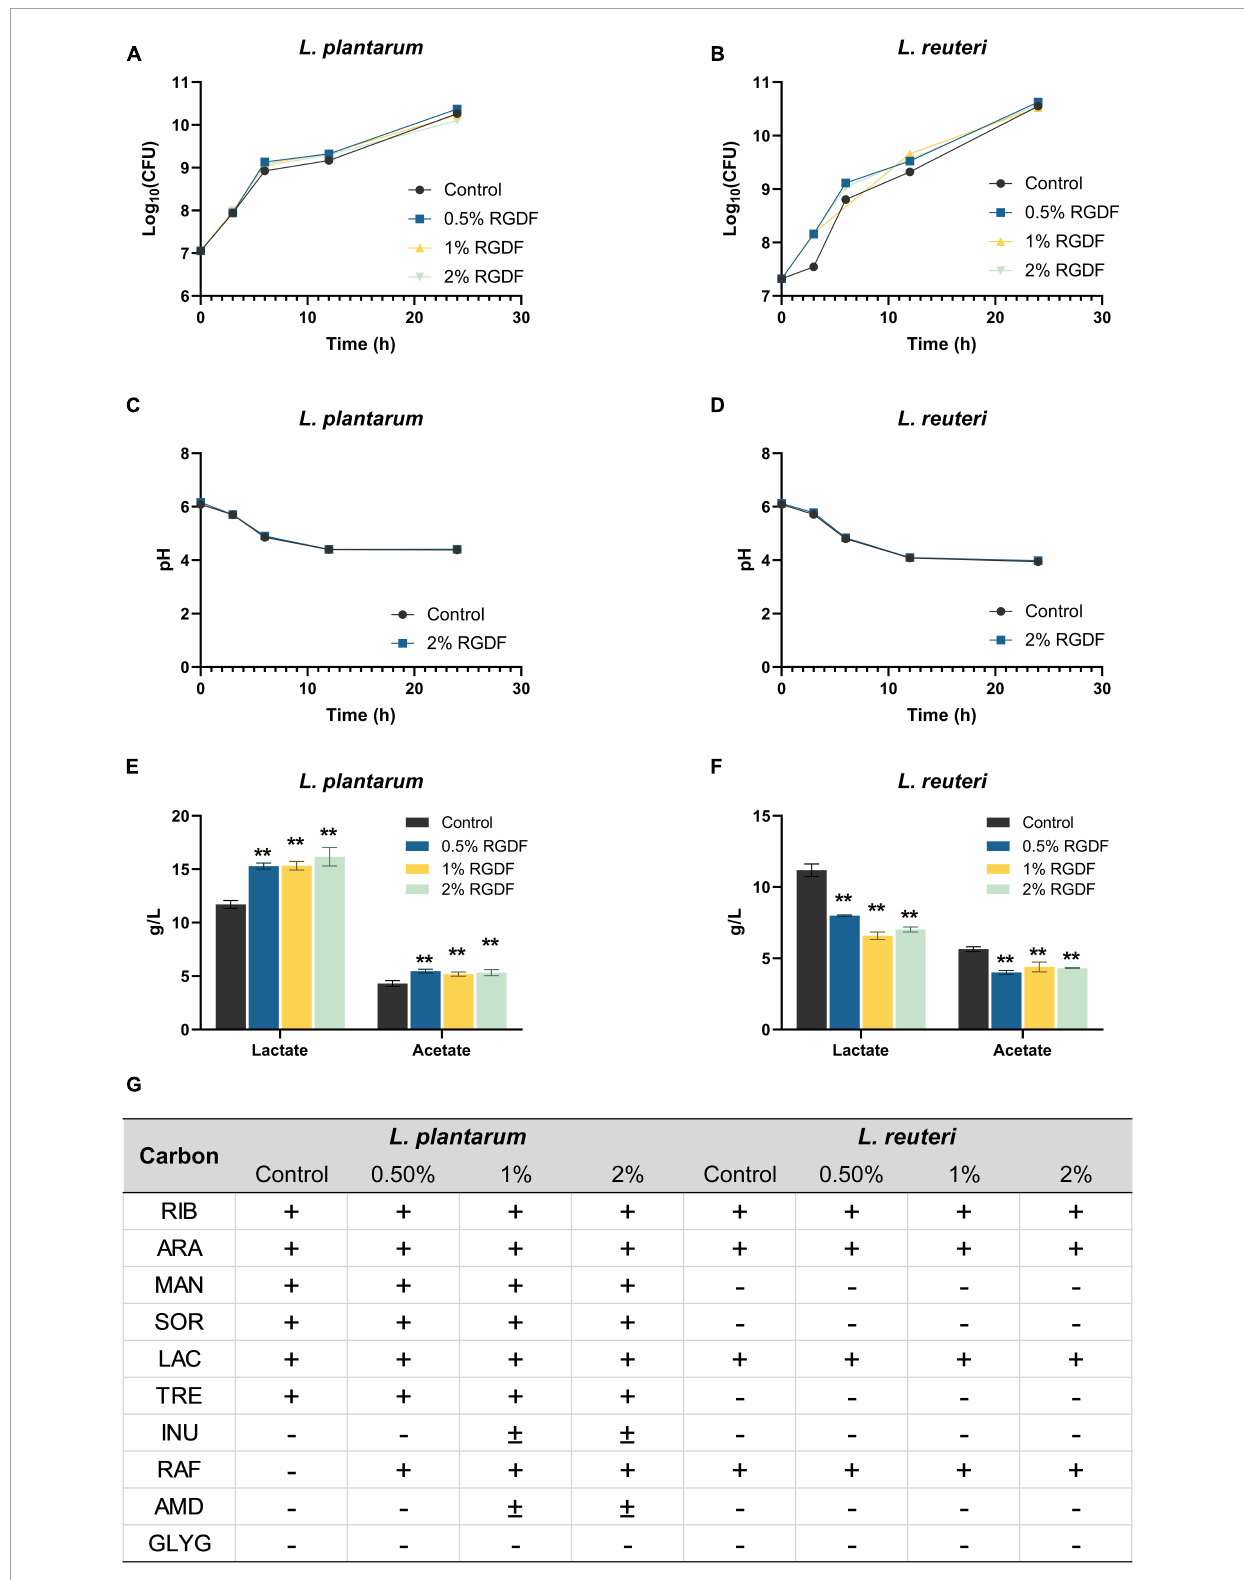
FIGURE1 Fermentation profiles of L. plantarum and L. reuteri . (A,B) Bacterial growth, (C,D) pH of cultured media, (E,F) lactate and acetate production, and (G) carbon source utilization. Differences were indicated at a significance level of 95% (*) and 99% (**), as determined by one-way ANOVA with Dunnett’s post-hoc analysis. Error bars represent standard deviation (SD). RGDF, red ginseng dietary fiber; RIB, D-ribose; ARA, L-arabinose; MAN, D-mannitol; SOR, D-sorbitol; LAC, D-lactose; TRE, D-trehalose; INU, inulin; RAF, D-raffinose; AMD, starch; GLYG, glycogen; +, positive; –,